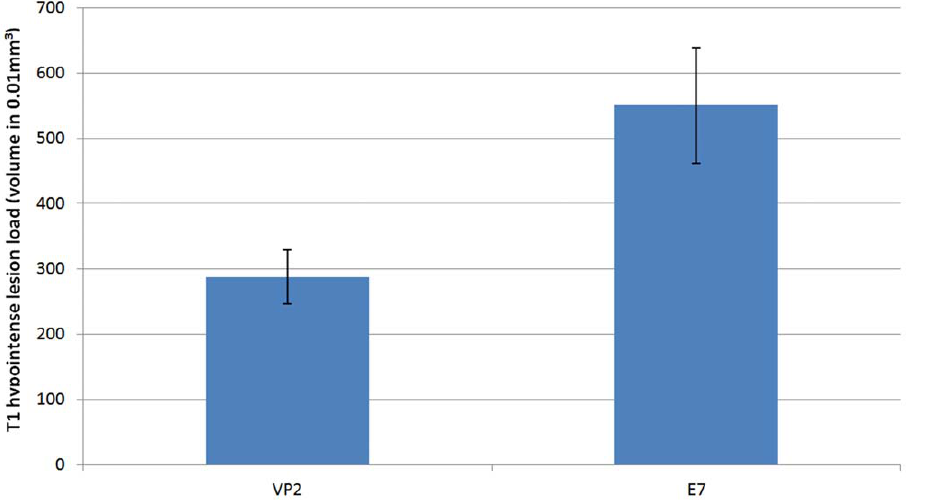
Figure 5. MRI T1BH volumetry results following peptide depletion. VP2 is the viral epitope recognized by over 75% of all CNS infiltrating CD8 T cells in the context of TMEV infection of C57BL6/J mice. E7 is an irrelevant viral petide. Note the significant reduction in T1BH formation by peptide-induced depletion (injection of VP2 peptide 1 day prior to infection). Y axis: volume units in 0.01 mm 3 . Error bars represent SD.